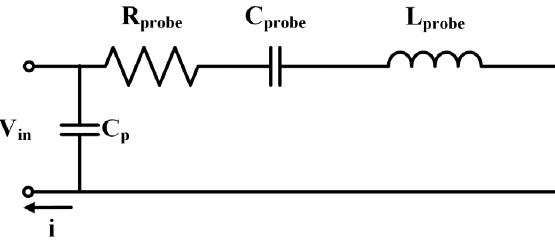
Figure 5. The equivalent RLC circuit of the tuning fork probe.